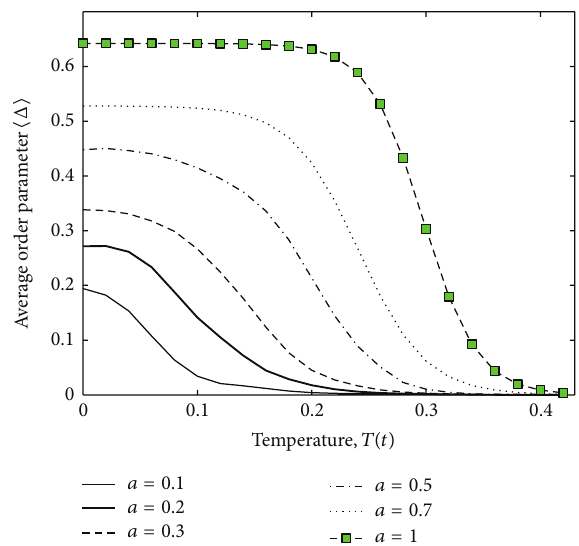
Figure 2: Spatially averaged superconducting order parameter ⟨Δ⟩ (in units of 𝑡 ) as a function of temperature for different values of 𝑎 (the fraction of doped semiconducting